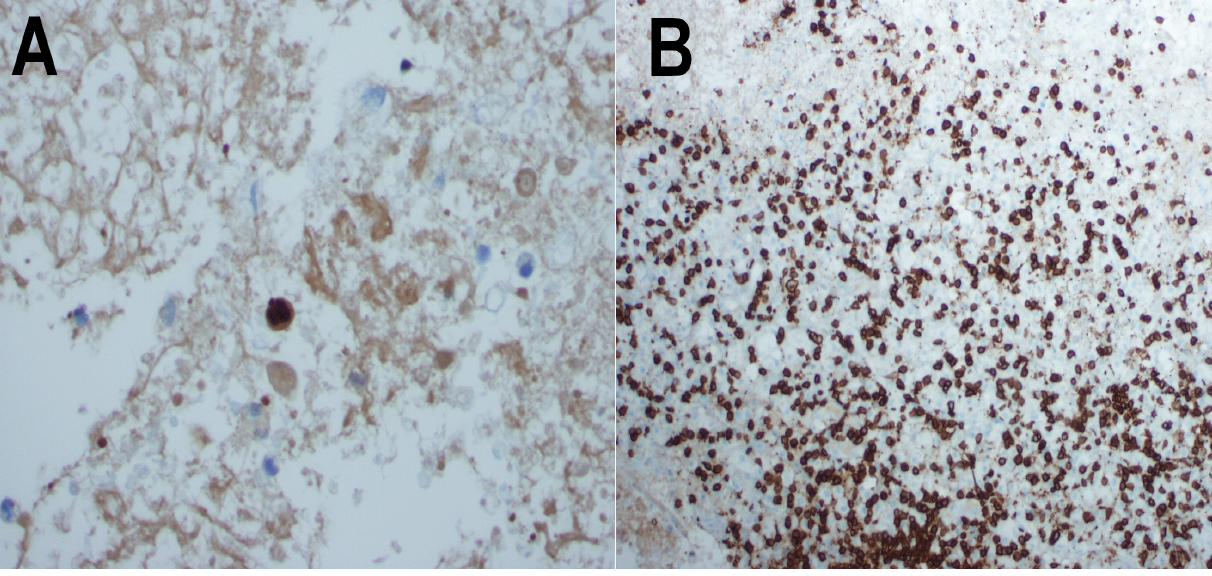
Figure 4. Patient 2 H&E staining necrotic tissue with scattered inflammatory cells consisting of mature lymphocytes and macrophages and some perivascular lymphocytes were present (not shown). Immunohistochemistry for T. gondii (400X) ( A ). Immunophenotyping of the inflammatory cells, showing again CD8+ over CD4+ T-cell predominance (100X) ( B